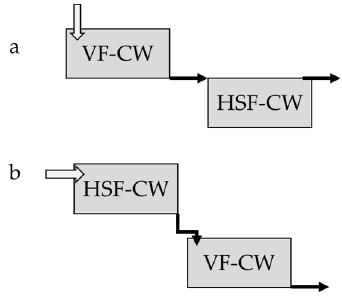
Figure 2. Diagram of hybrid constructed wetland where, ( a ) is vertical flow SF ‐ CWs followed by horizontal flow SF ‐ CWs and ( b ) is horizontal flow SF ‐ CWs followed by vertical flow SF ‐ CWs.